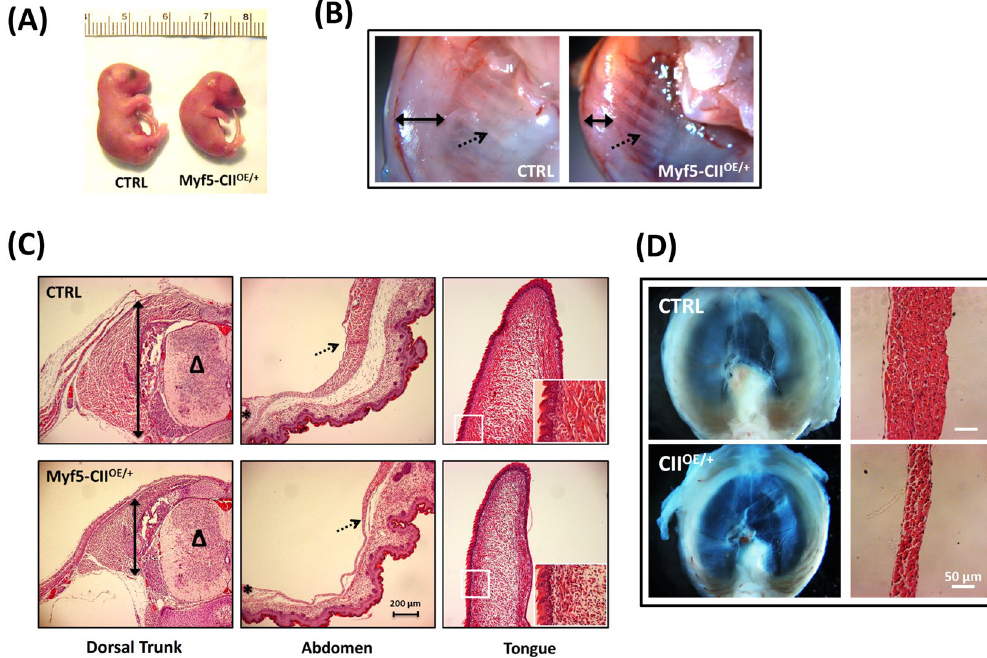
Figure 3. Myf5-Cre driven COUP-TFII overexpression impaired skeletal muscle development in vivo . ( A ) Phenotypical differences of control littermate (CTRL) and My5-COUP-TFII OE/ + fetus. ( B ) Fixed and de- skinned fetus under dissection microscope. Bold arrow: body wall; dotted arrow: ribs. ( C ) H&E staining of dorsal trunk, abdomen and tongue muscles, sequentially. Bold arrow: the thickness of psoas major muscle; dotted arrow: abdomen muscle; ∆ spinal cord; * umbilical ring. Enlarged square area of the tongue was shown on the bottom right site. ( D ) Dissection microscope imaging of whole diaphragm and H&E staining was shown in right panel. Animals were delivered by cesarean section on the 18 th day of